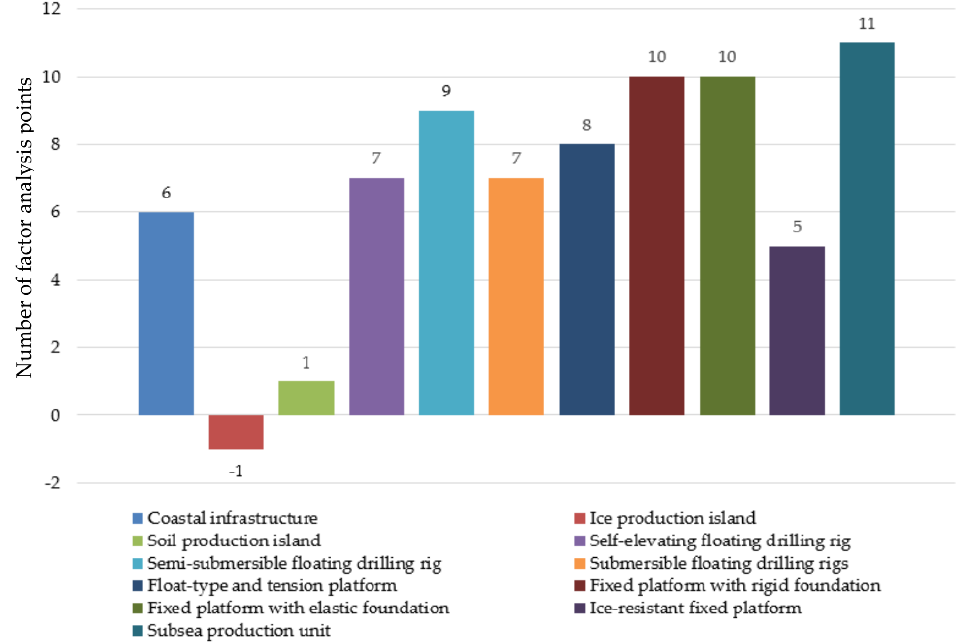
Figure 4. The qualitative analysis of the arrangement system for the Avaldsnes section.